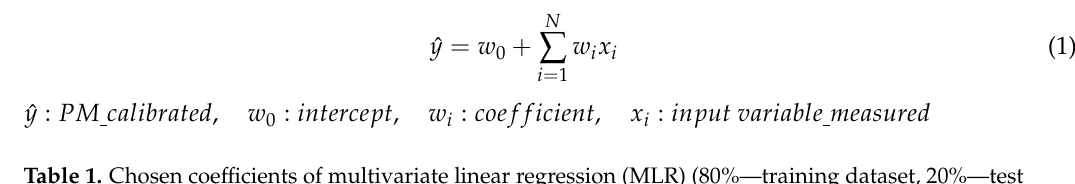
Table 1. Chosen coefficients of multivariate linear regression (MLR) (80%—training dataset, 20%—test dataset, shuffled method, 5 min. sampling interval